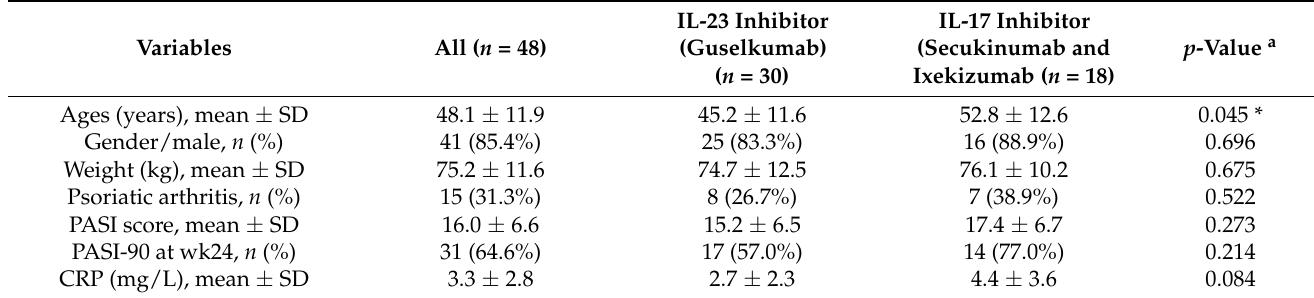
Table 1. Demographics and characteristics of study groups.